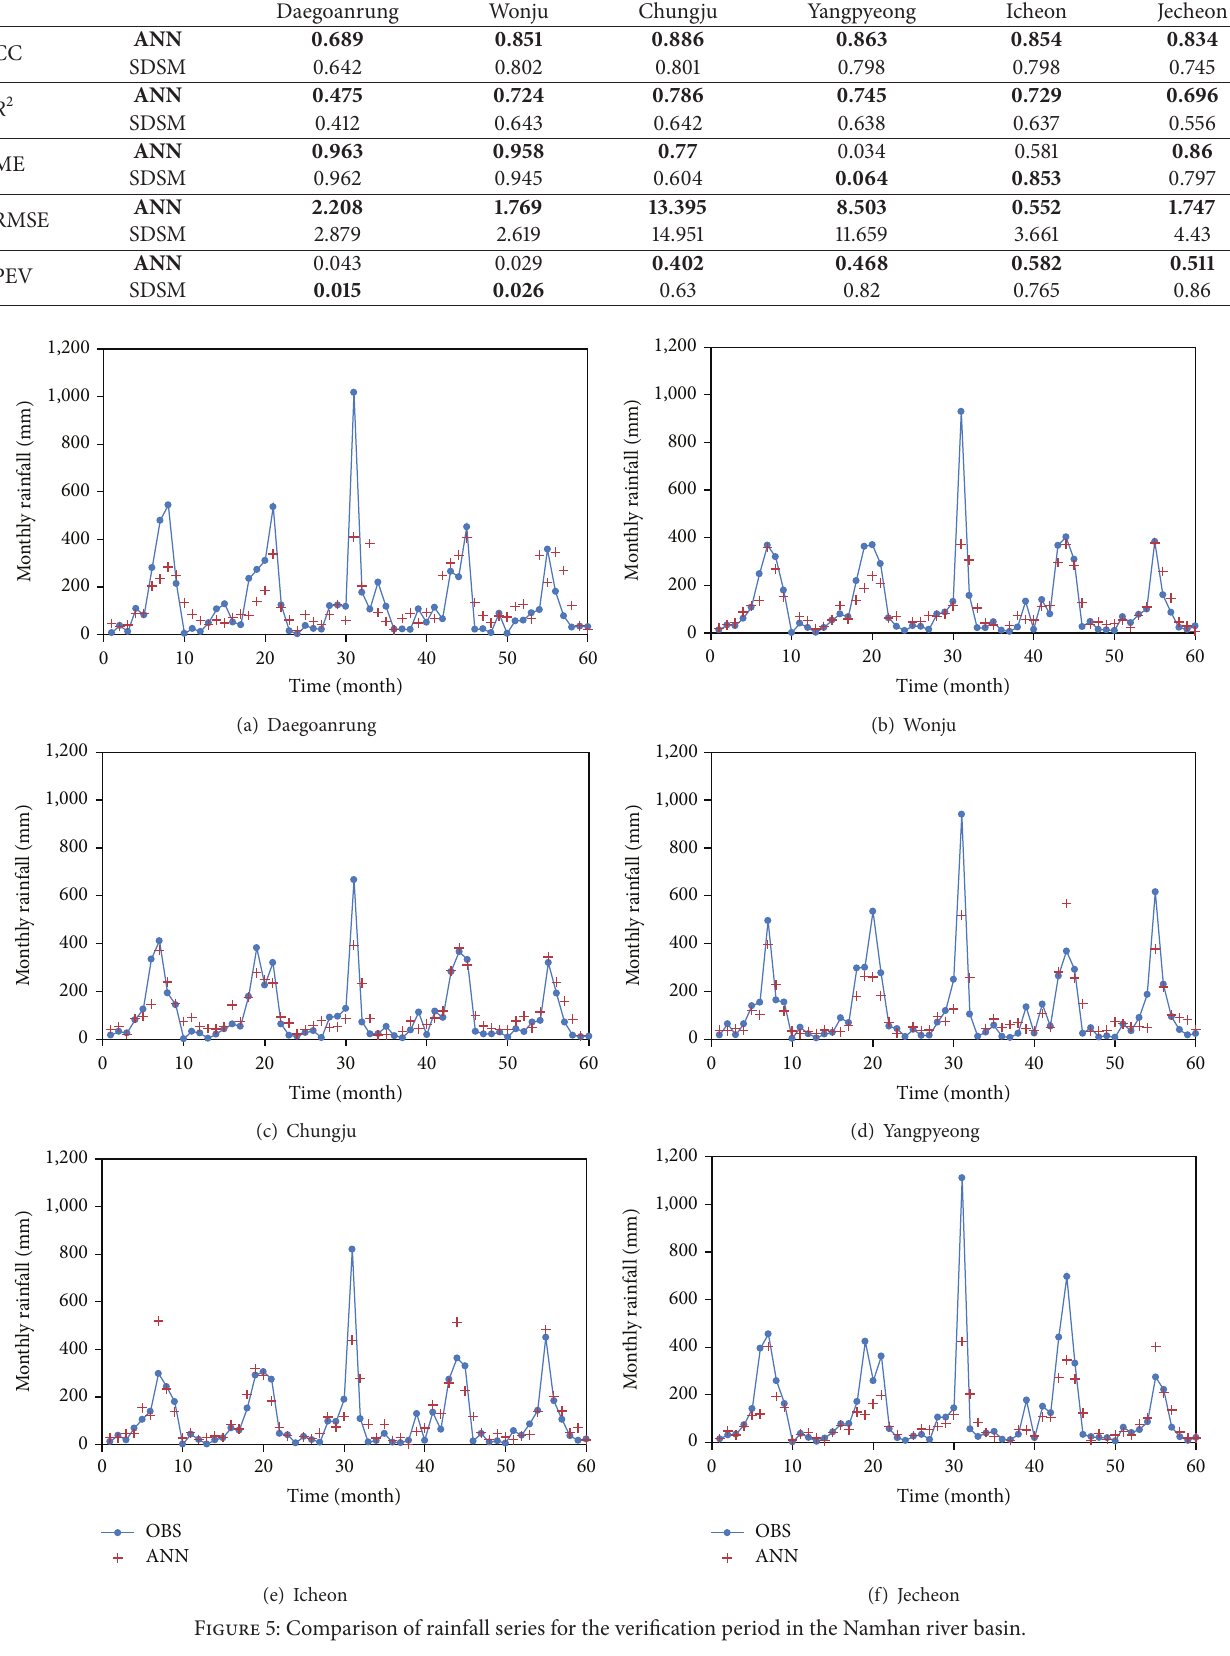
Table 2: Comparison of CC, 𝑅 2 , ME, RMSE, and PEV of ANN and SDSM.